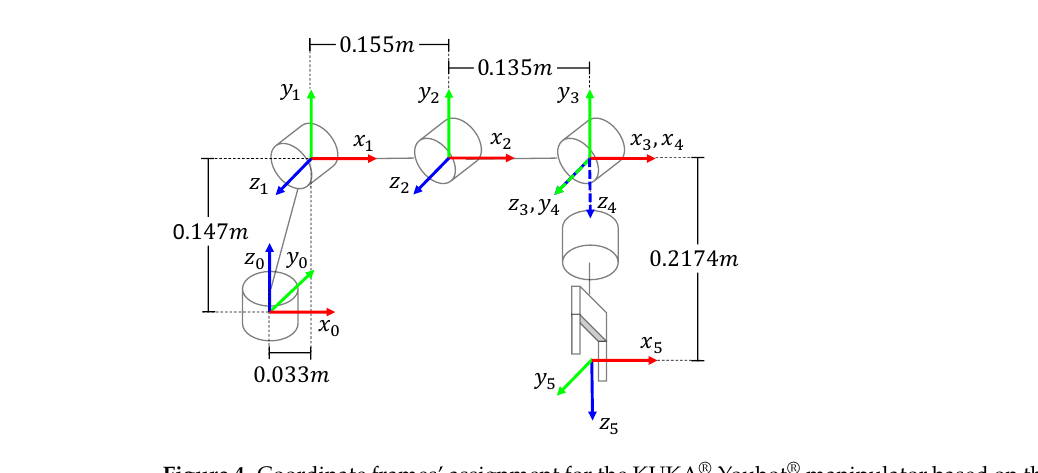
Figure 4. Coordinate frames’ assignment for the KUKA ® Youbot ® manipulator based on the technical specifications manual. Table 2. DH table for the KUKA ® Youbot ®